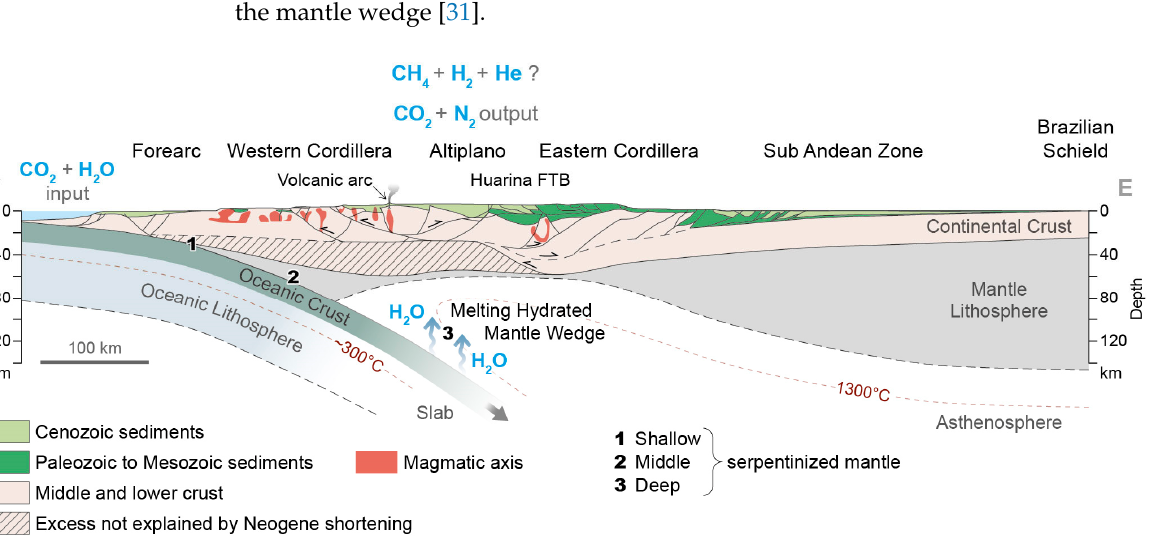
much warmer than the subducting lithosphere, and the hydrated facies are unstable when